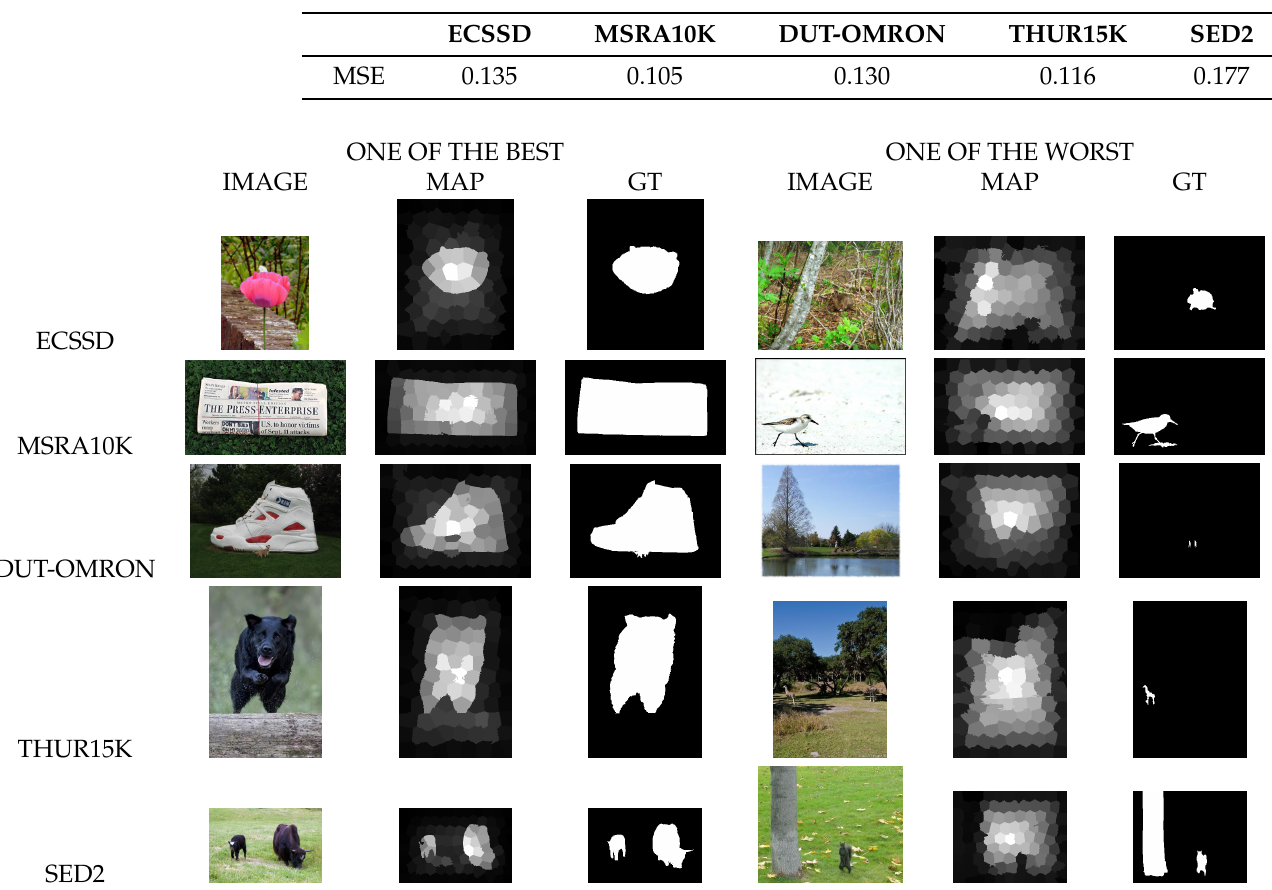
Table 1. Our model’s MSE measure results for ECSSD, MSRA10K, DUT-OMRON, THUR15K and SED2 datasets (for MSE, the smaller value is the best).